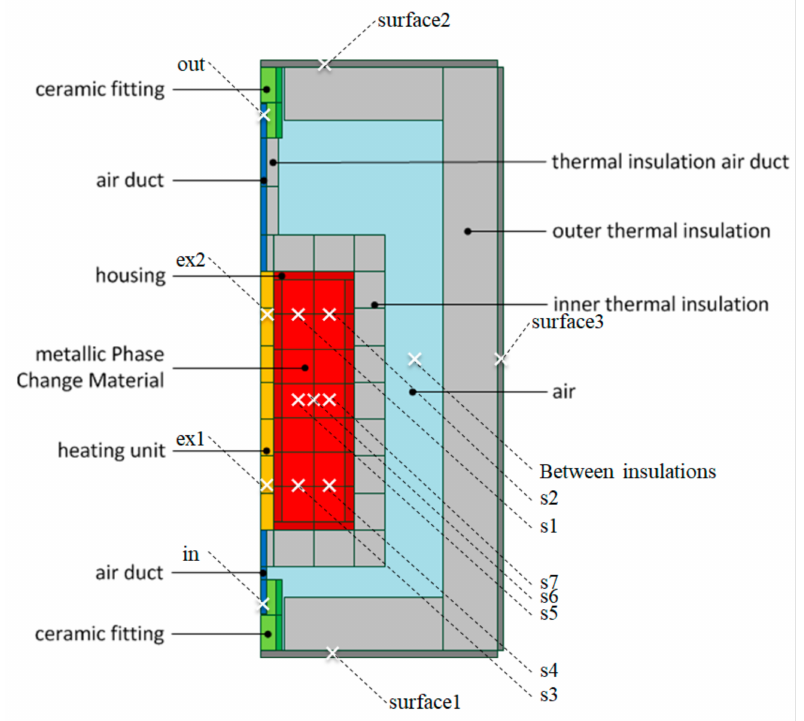
Figure 5. Discretisation of relevant components within simulation model and sensor